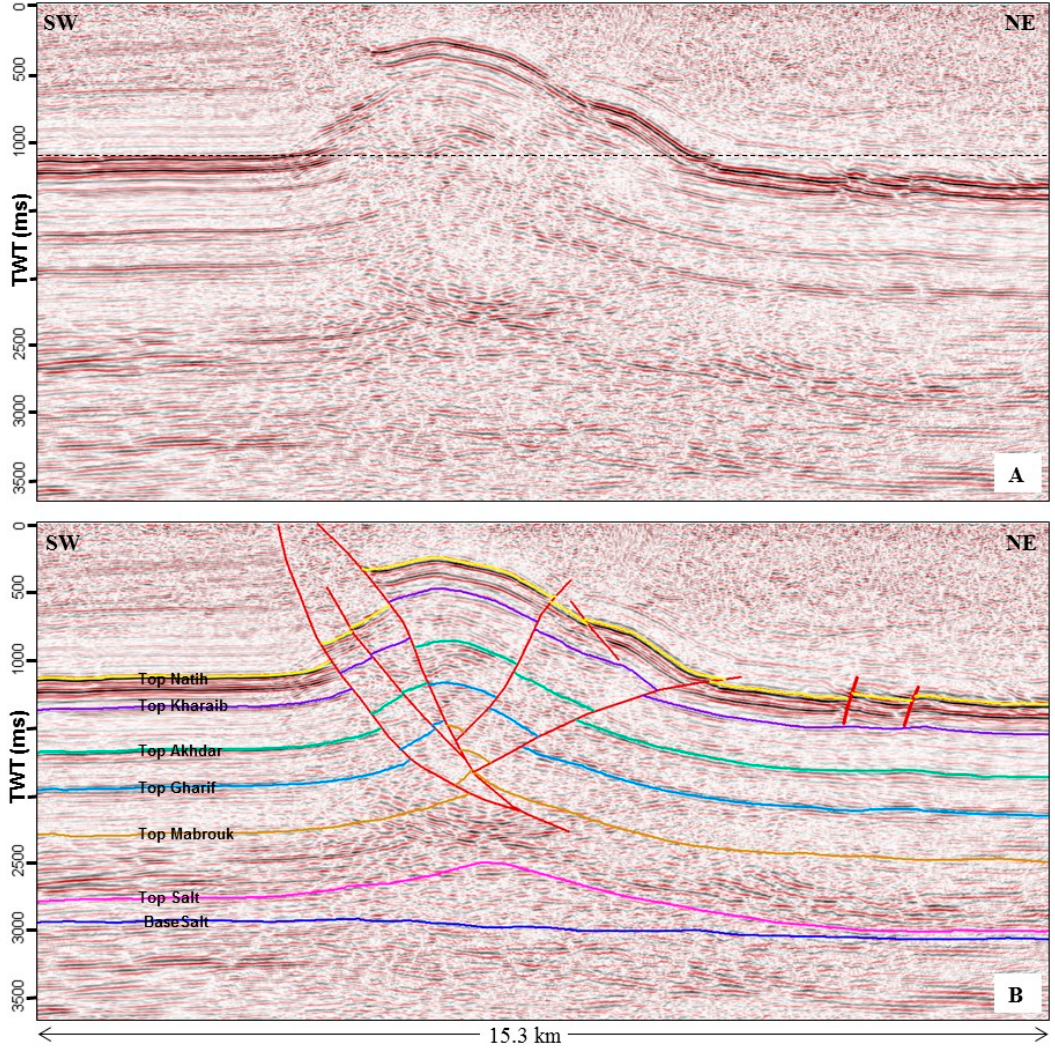
Figure 13. ( A ) Uninterpreted and ( B ) interpreted section of seismic line 3. The location of the section is shown in Figure 6. Note that the northern side of top Natih is lower than the southern side.